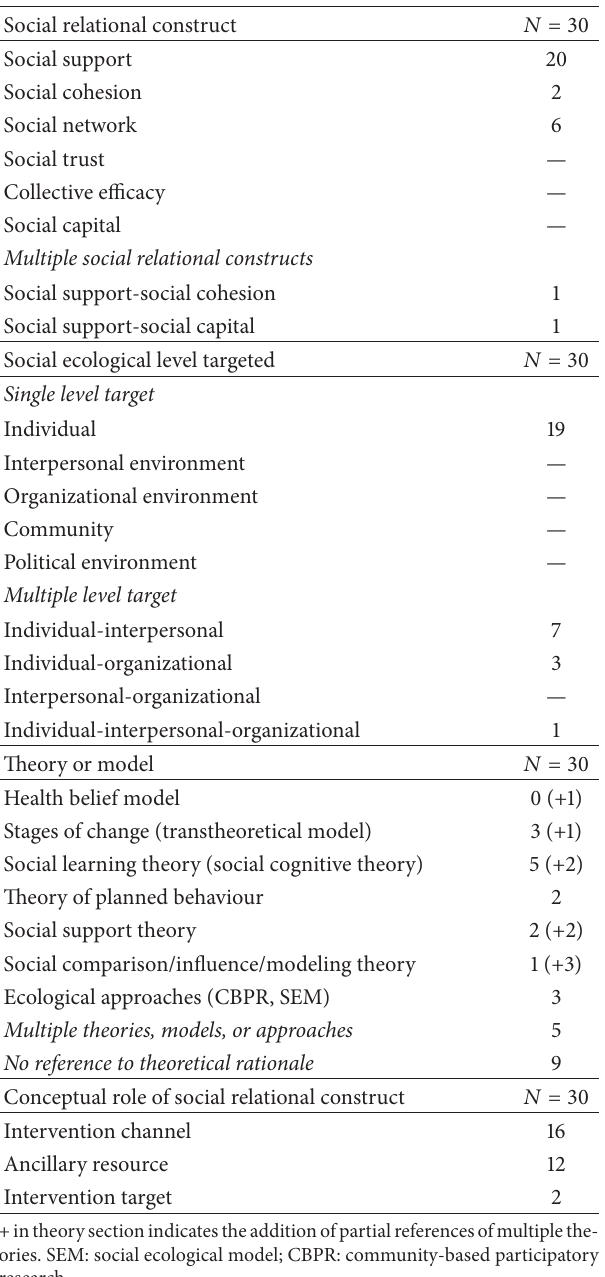
Table 2: Descriptive overview of intervention studies found per- taining to social relational constructs and